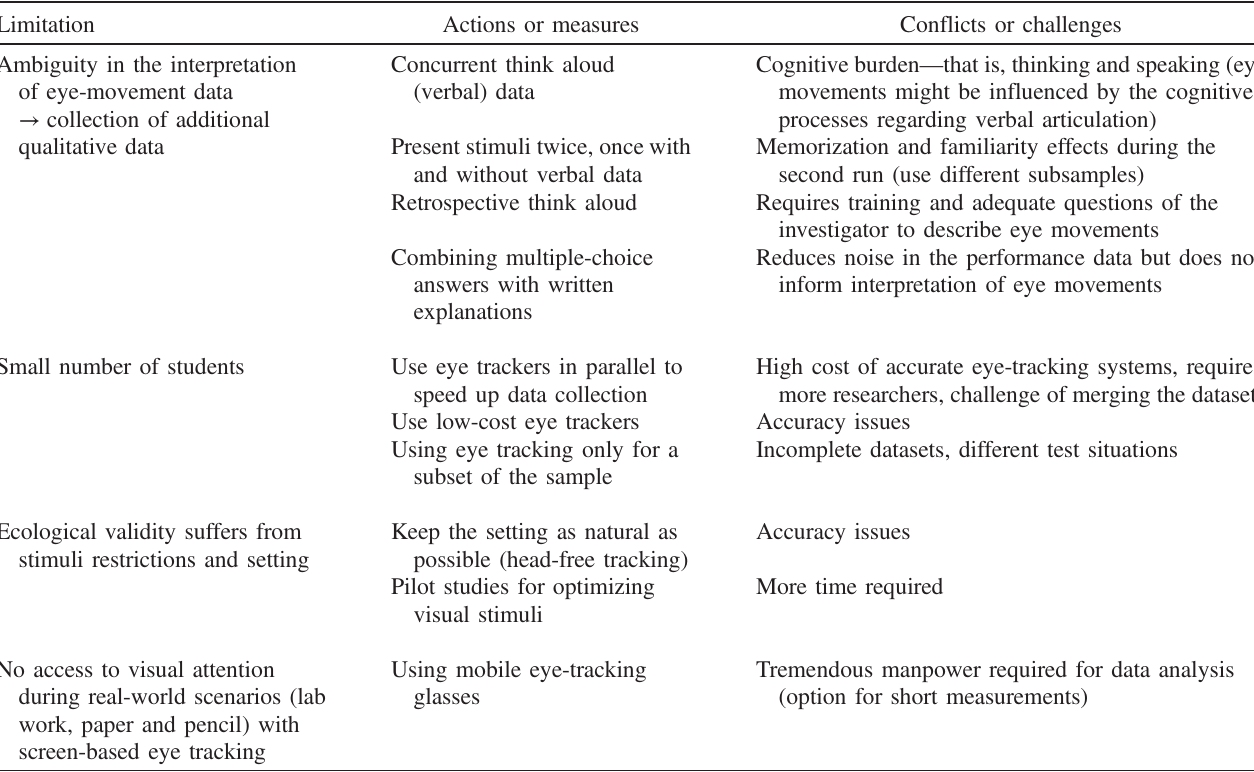
TABLE VI. Methodological limitations of eye tracking and how researchers have dealt with